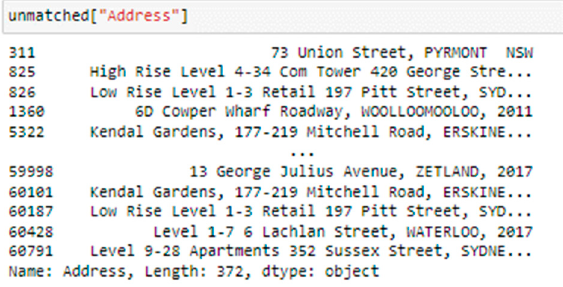
Figure 15. Sample of unmatched addresses.